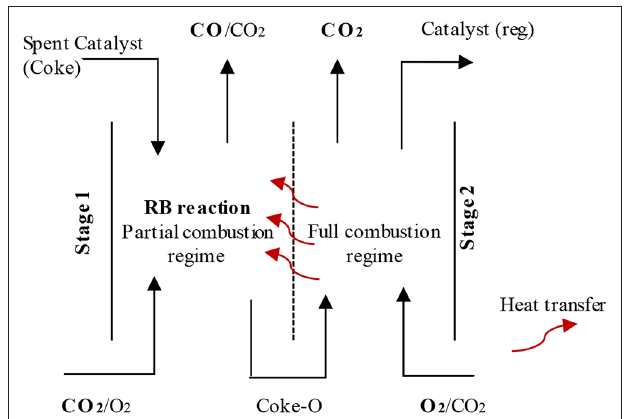
FIGURE 9 | Two-stage FCC regeneration with diathermy wall provides heat transfer between the stages, reproduced from Silva et al. (2015) with permission from